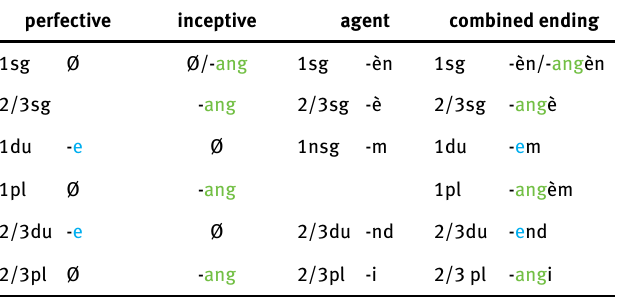
Table 8: Proximate inceptive suffixes perfective inceptive agent combined